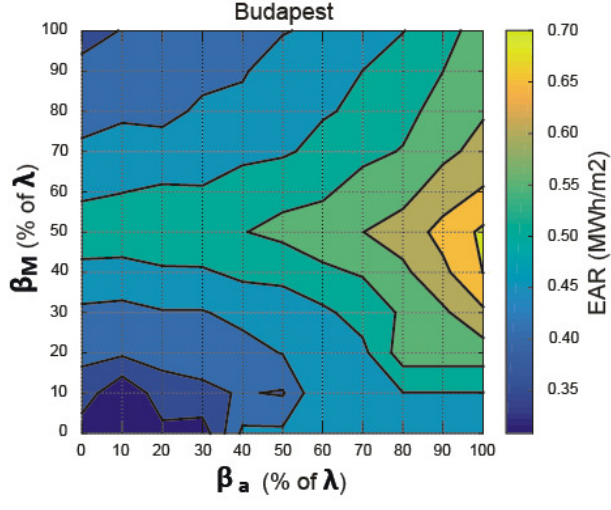
Figure 9. EAR in Budapest.